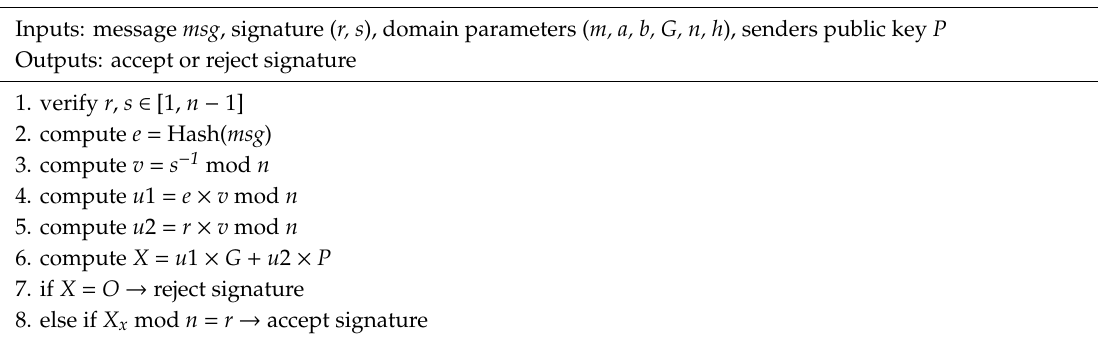
Algorithm 2. Elliptic Curve Digital Signature